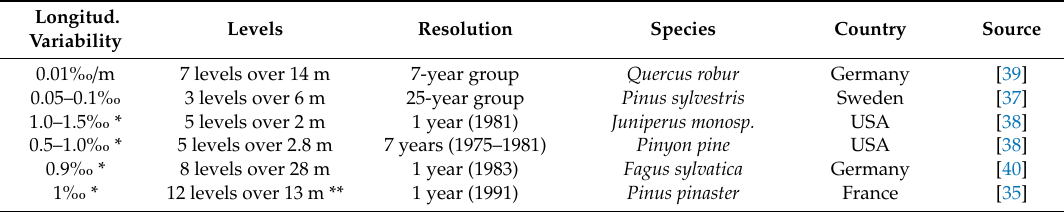
Table 2. Longitudinal δ 13 C variability in tree-ring studies. The values in the first column represent the ranges of smallest to largest average isotope composition among the di ff erent height levels being